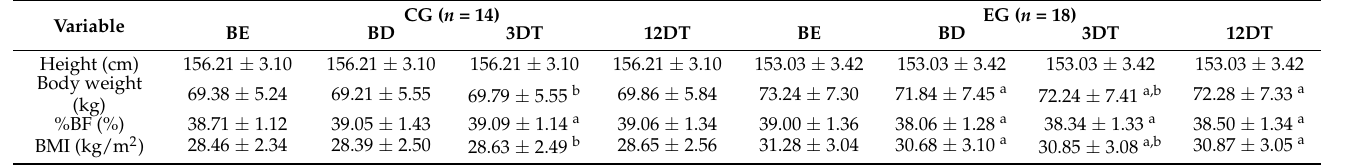
Table 1. Body compositions after 9 months of exercise program and over 12 months of detraining (mean ±